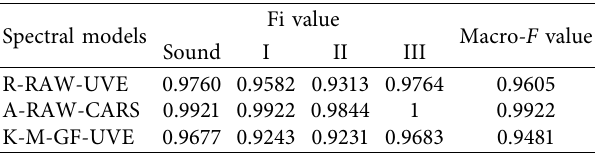
Table 5: Macro -F 1 results of SVM model discrimination based on R-RAW-UVE, A-RAW-CARS, and K-M-GF-UVE spectra. Spectral